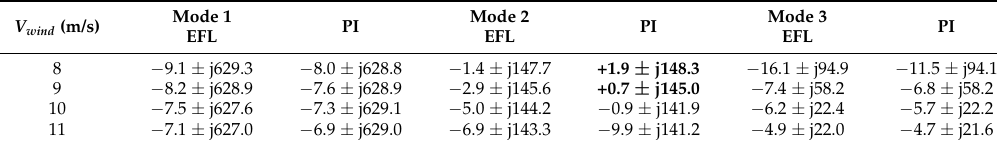
Table 1. System modes for a compensation level ( K ) of 70%.